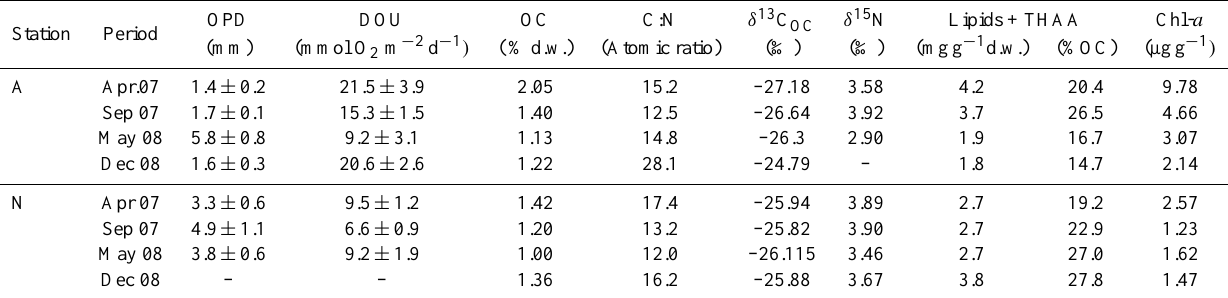
Table 3. Results of the different environmental parameters analysed within sediments of both Stations A and N over the four sampling campaigns. Oxygen penetration depth (OPD), dissolved oxygen uptake (DOU) and analyses on particulate organic matter from the top half-centimetre of sediment: organic carbon (OC), carbon and nitrogen stable isotopic ratios ( δ 13 C OC vs. δ 15 N), sum of lipids and total hydrolysable amino-acids (THAA) contents for dry-weight sediment (d.w.) and contribution to the OC